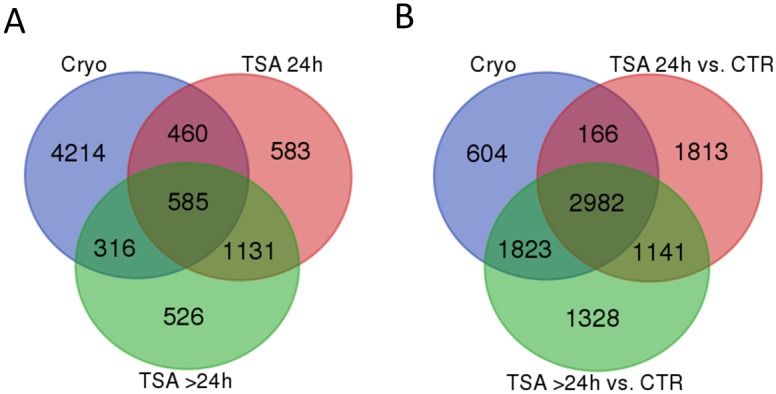
Venn diagram of differentially expressed genes between–A- preceding treatments and B- fresh control MSCs.A—The genes expression level was compared between the frozen and non-frozen control, the TSA treated cells and frozen control and the cells further cultured following TSA removal vs. the TSA treated cells; B- in comparison to the fresh (non-frozen) MSCs.CTR–fresh (not cryopreserved) controlCryo–cryopreserved, not treated cellsTSA–cells treated with TSA for 24hTSA>24h –cells treated with TSA for 24h and further cultured following TSA removal.